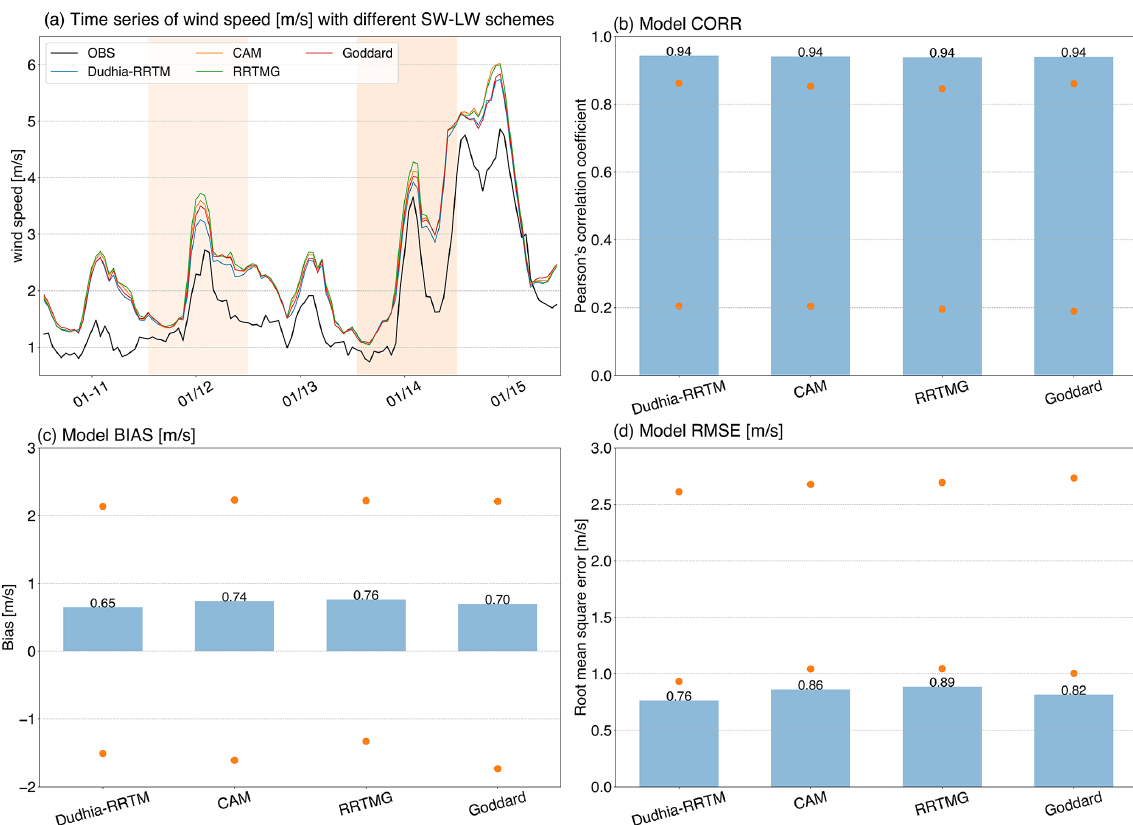
Figure 7. Same as Fig. 3, but for the radiation